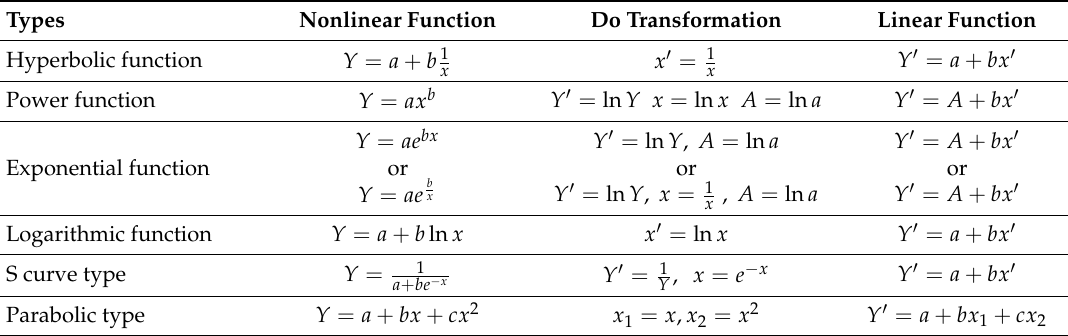
Table 4. Transformation of the nonlinear regression and linear